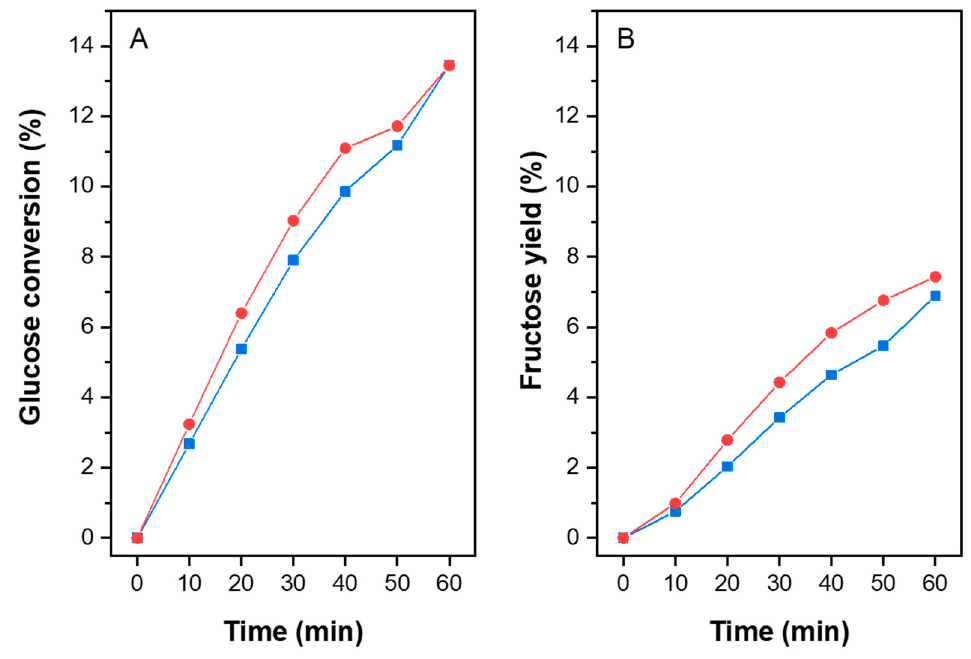
Figure 7. The results of the catalytic activity tests at 100 °C, at pH 7.0, in batch reactors for ZIF-8 (square) and ZIF-8-HT (circle) showing glucose conversion ( A ) and fructose yield ( B ). Yields of mannose and HMF are close to zero and therefore not included.